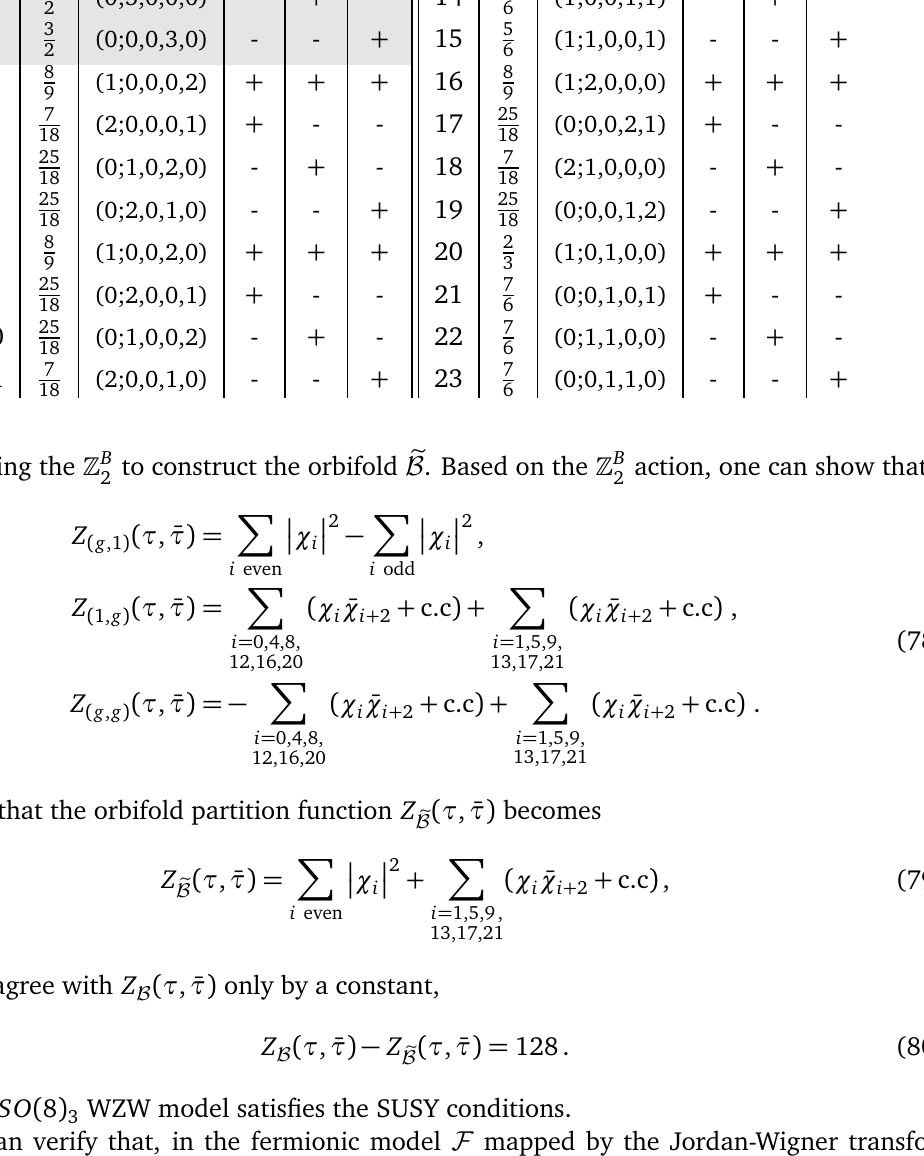
subgroup of the center symmetry (cid:90) 2